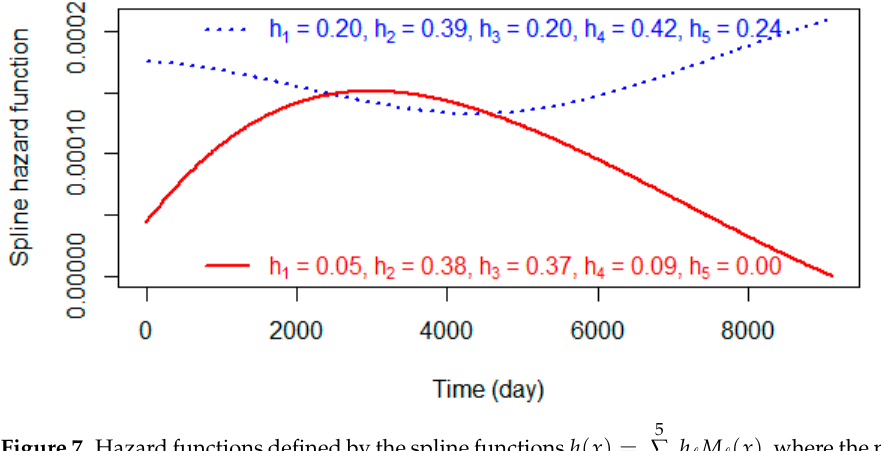
Figure 7. Hazard functions defined by the spline functions ℎ(𝑥) = ∑ ℎ ℓ 𝑀 ℓ (𝑥) (cid:2873) ℓ(cid:2880)(cid:2869) , where the param- eters were estimated by the breast cancer data analysis of Emura et al. [122].